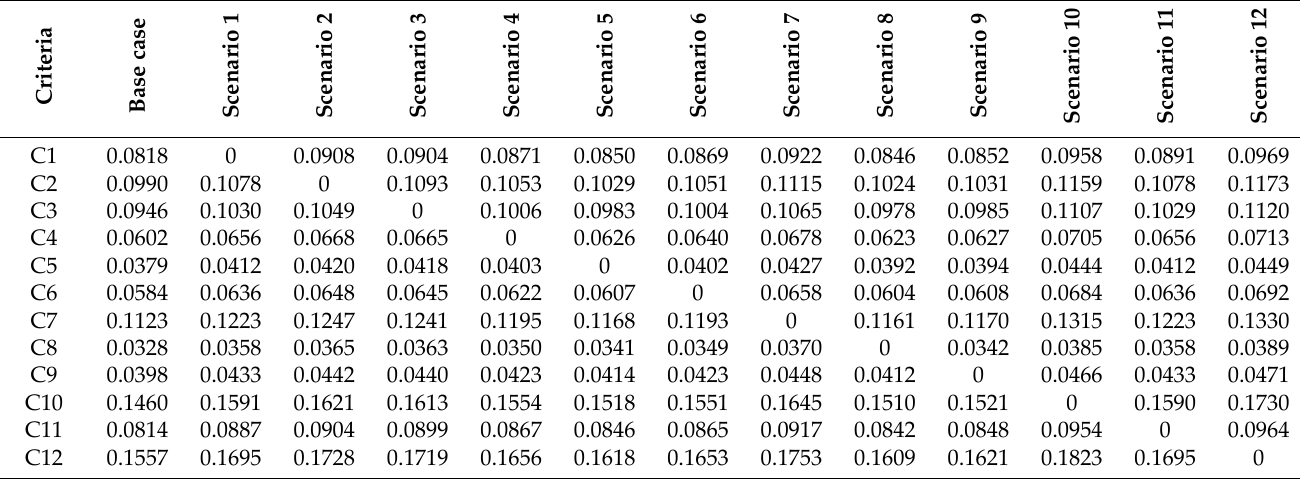
Table 10. The weights of criteria for all scenarios.